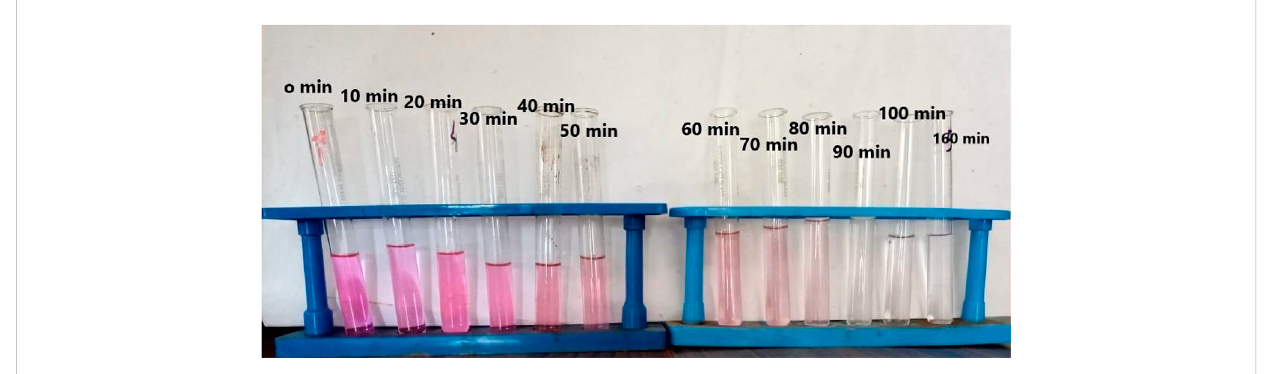
FIGURE 5 Degradation of dye under UV irradiation.